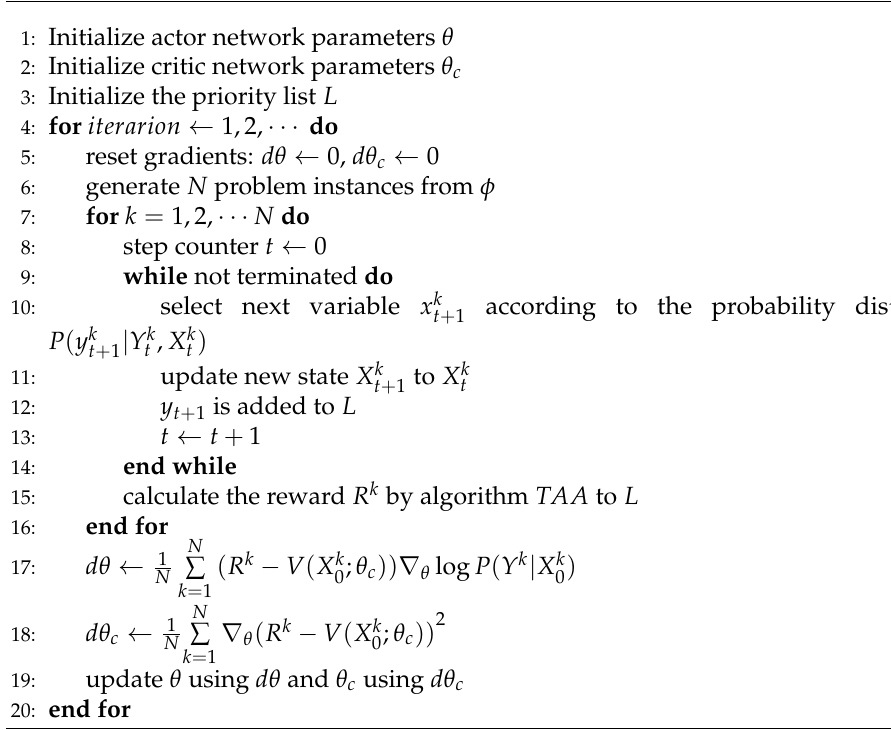
Algorithm 2 Actor-critic